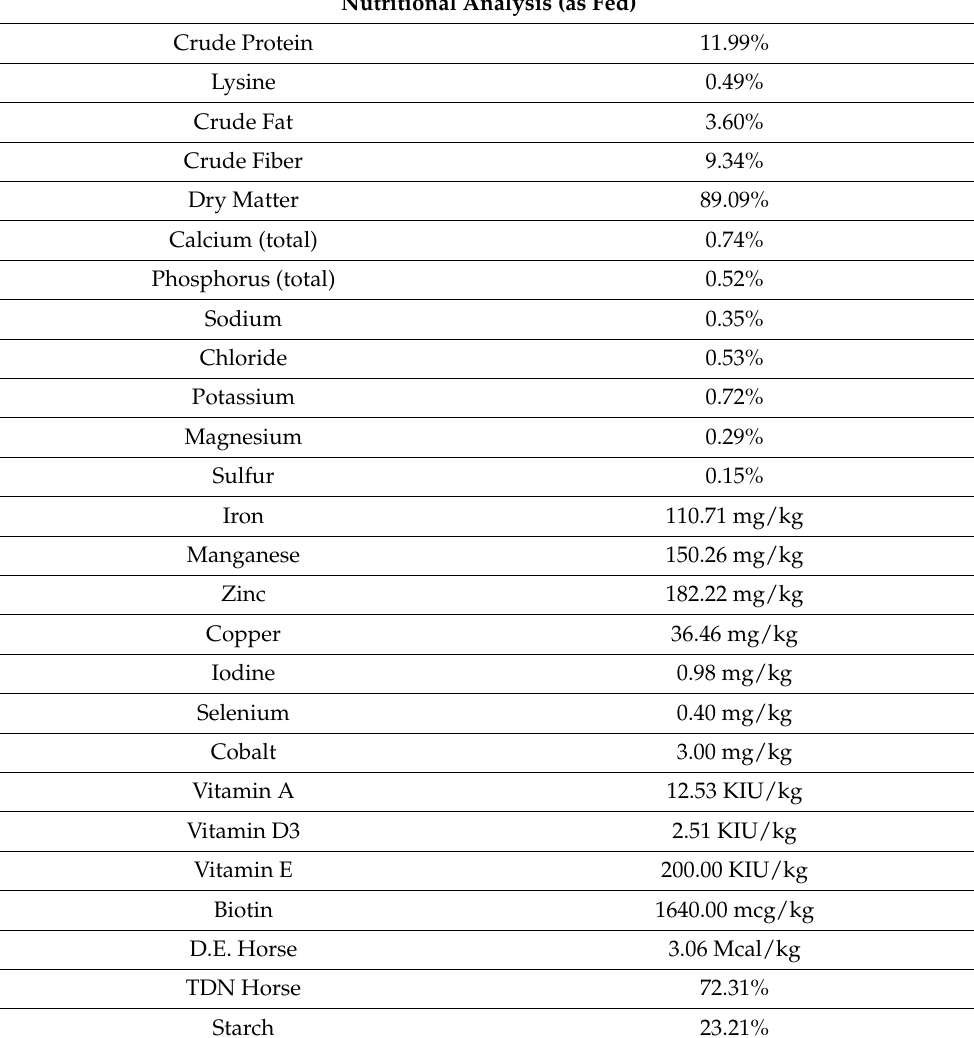
Table 1. Horse ration pellets